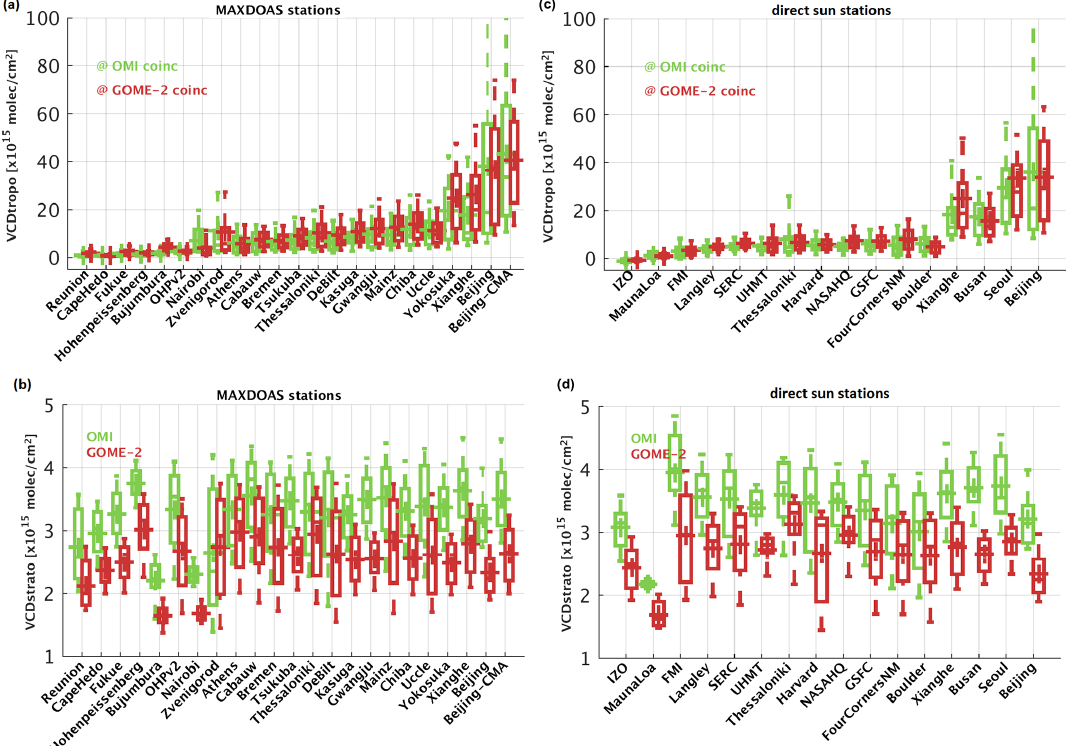
Figure 3. NO 2 columns at the various ground-based stations (MAX-DOAS in panels a, b and direct sun in panels c, d ). (a) Box-and-whisker plot of the ground-based tropospheric NO 2 columns (obtained by subtracting the satellite VCDstrato in the case of direct sun data) and (b) box-and-whisker plot of the stratospheric NO 2 content derived from satellite instruments. OMI data in green; GOME-2A data in dark red. The box-and-whisker plots are defined as follows: crosses for the mean values, horizontal lines for the median, boxes for the 25 and 75 percentile and vertical lines for the 9 and 91 percentile. Stations are ordered by increasing values of the VCDtropo columns.